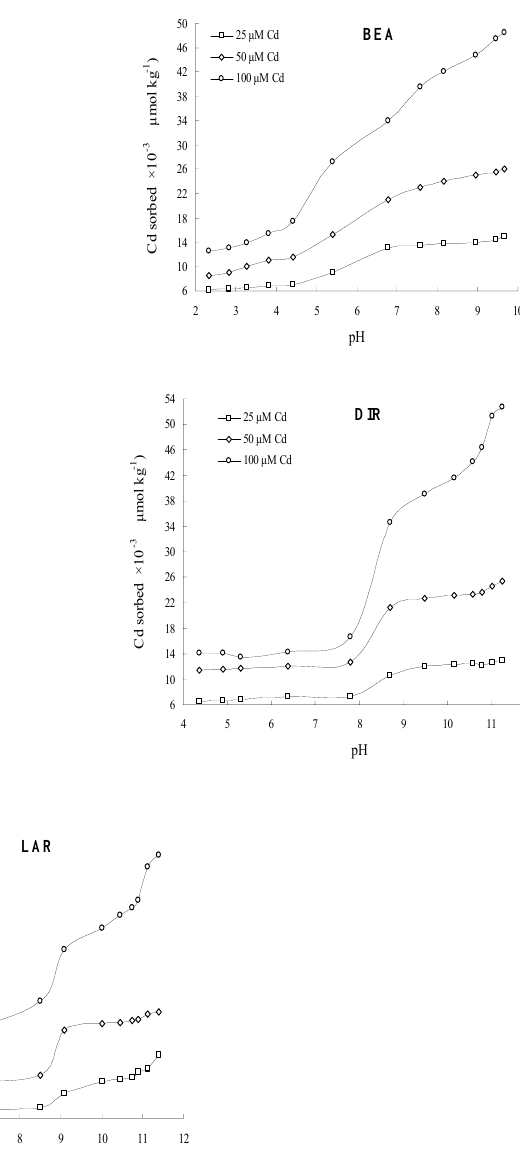
FIGURE 3 . Effect of pH on Cd sorption in